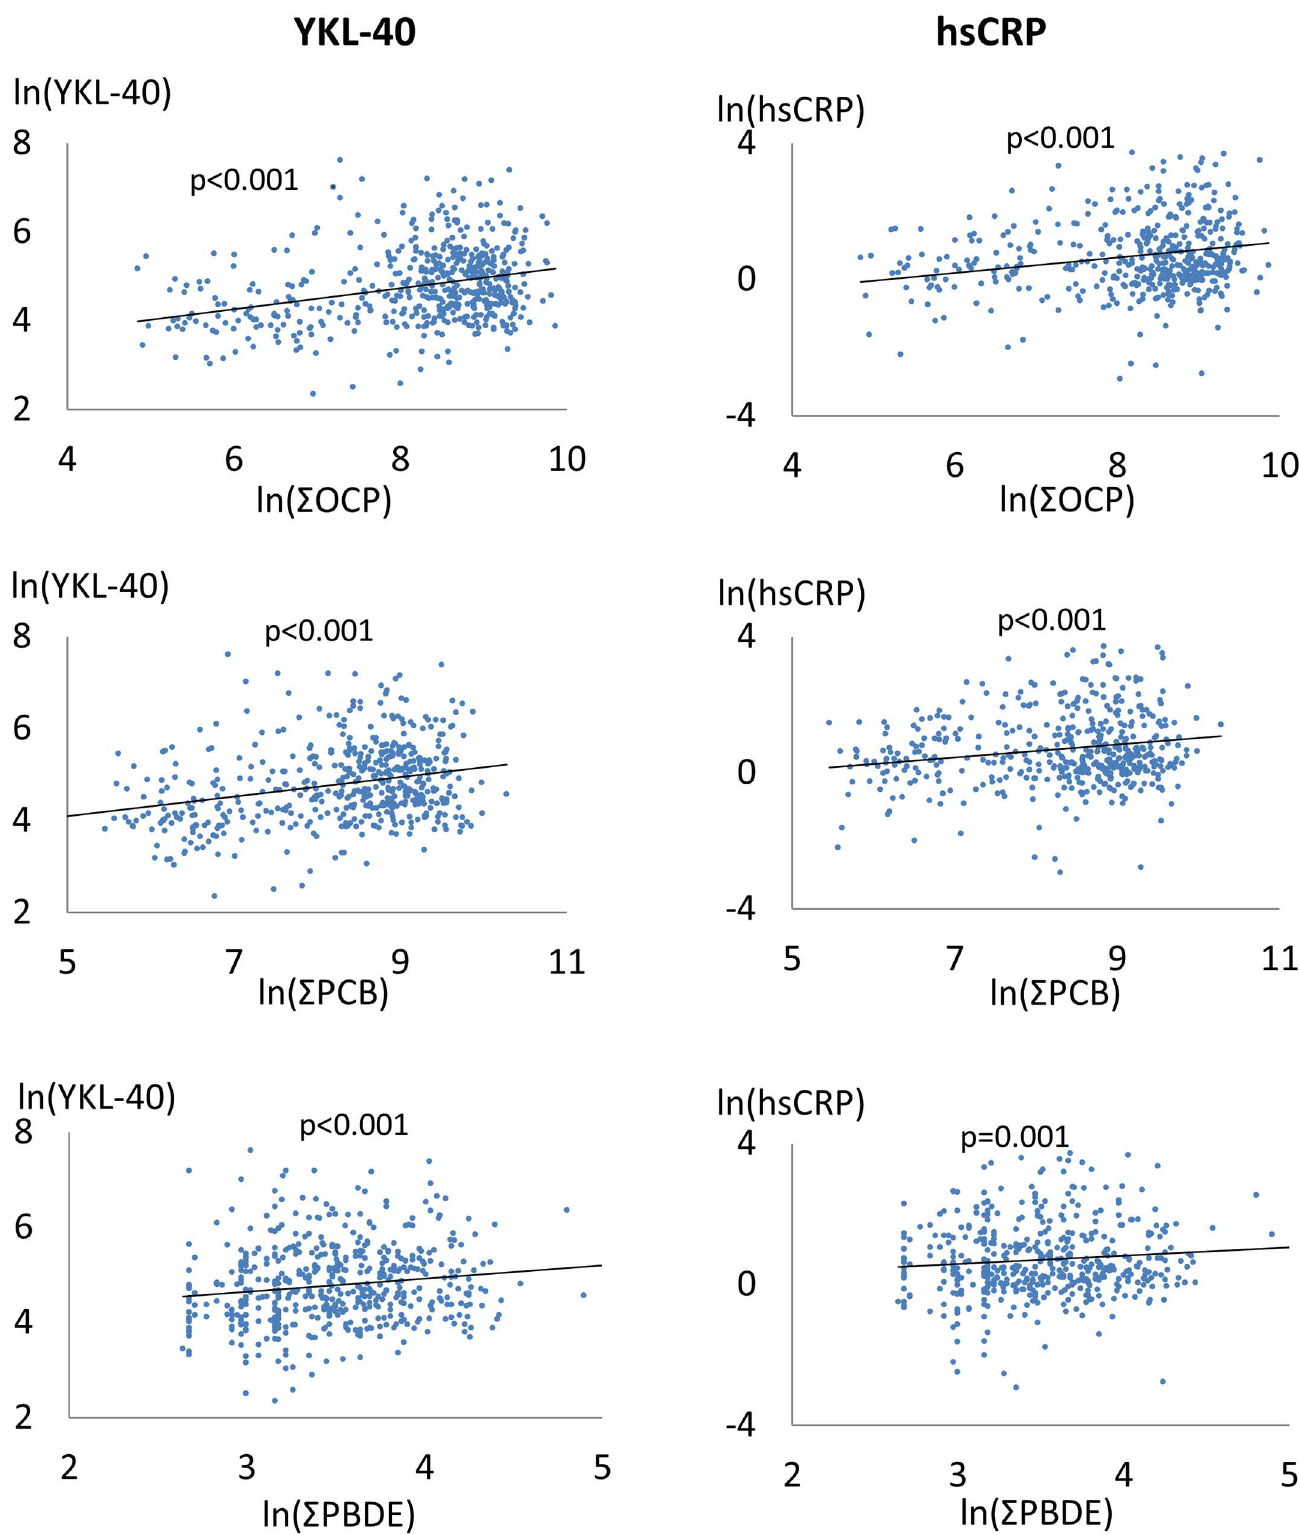
Fig 2. The correlation between the two markers of inflammation and Σ OCP, Σ PCB and Σ PBDE. Lineartrendlineis shown, p- value is for trend. Ln-transformation solely for presentation.